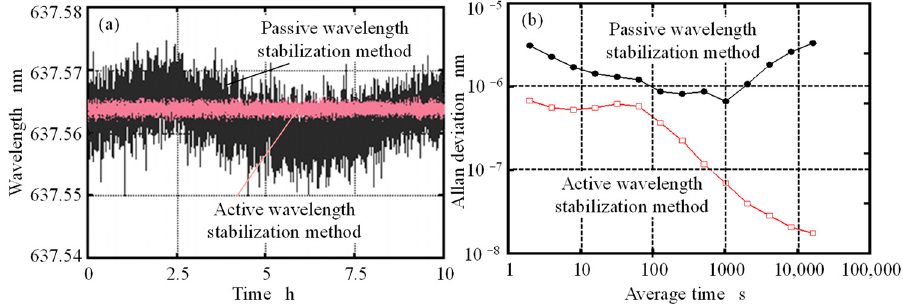
Figure 11. ( a ) Stability of the wavelength with passive and active wavelength stabilization methods and ( b ) the Allan deviation.